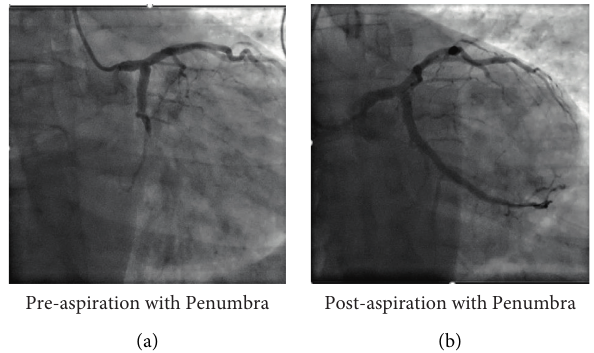
Figure 1: Case 1: 42-year-old male patient presenting with inferolateral STEMI. STEMI, ST segment elevation myocardial